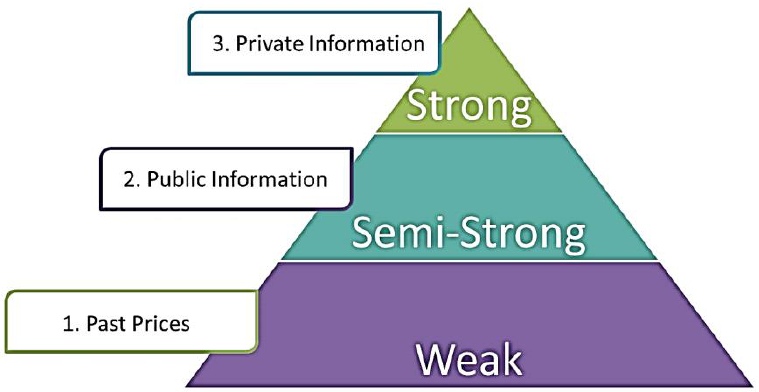
Figure 1. Basic Forms of Market Efficiency.